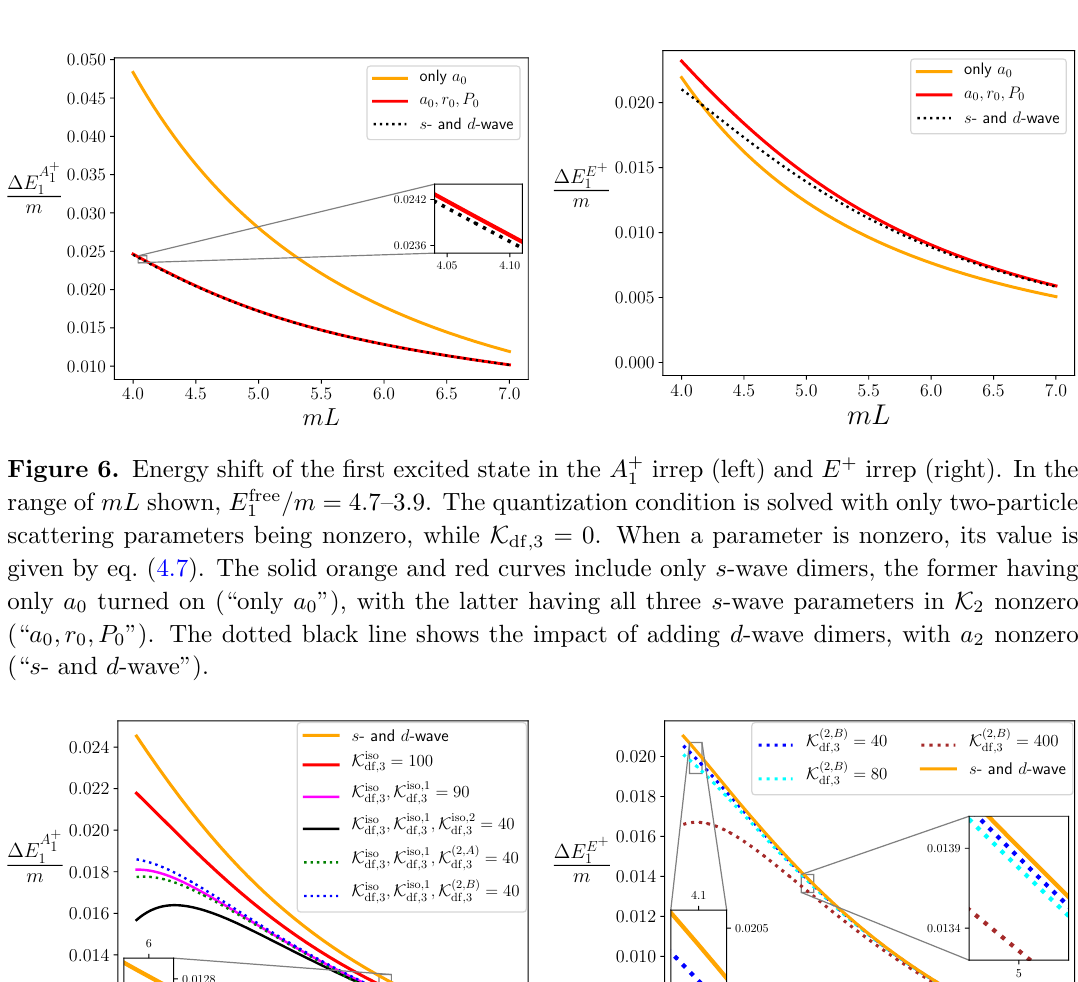
irrep (left) and E + irrep (right) with var- 1 . The two-particle scattering parameters are given by eq. (4.7) K df ; 3 parameters is explained by the legend, with the convention K df ; 3 (2 ;A ) (2 ;B ) iso ; 1 iso ; 2 iso = 100, = 90, and = 40, while = = df ; 3 df ; 3 df ; 3 df ; 3 df ; 3 K K K K K